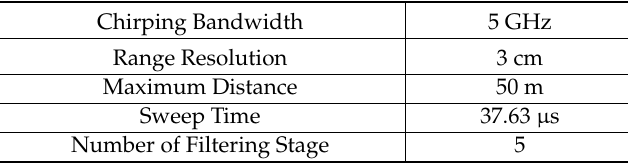
Table 2. Simulation environment in the proposed